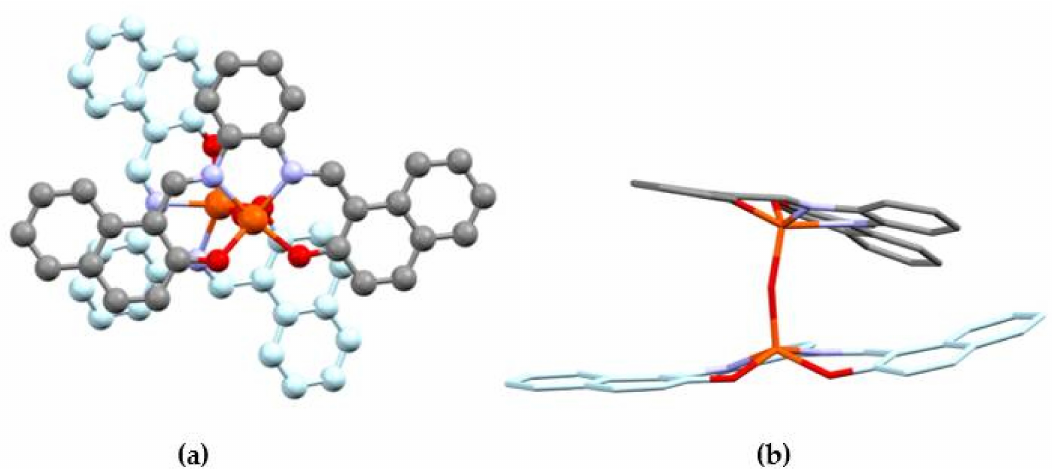
Figure 2. ( a ) Crystal structure of SYML1-Fe, top view. ( b ) Side view of SYML1-Fe. One ligand is shown in light blue and hydrogens are not shown for clarity. Carbon: gray. Oxygen: red. Nitrogen: blue. Iron: